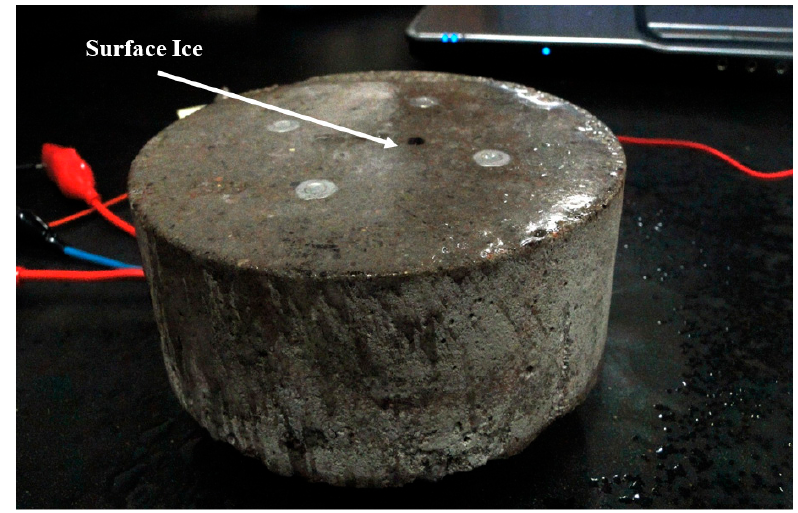
Figure 8. Surface ice formation on cold SP-I sensor.